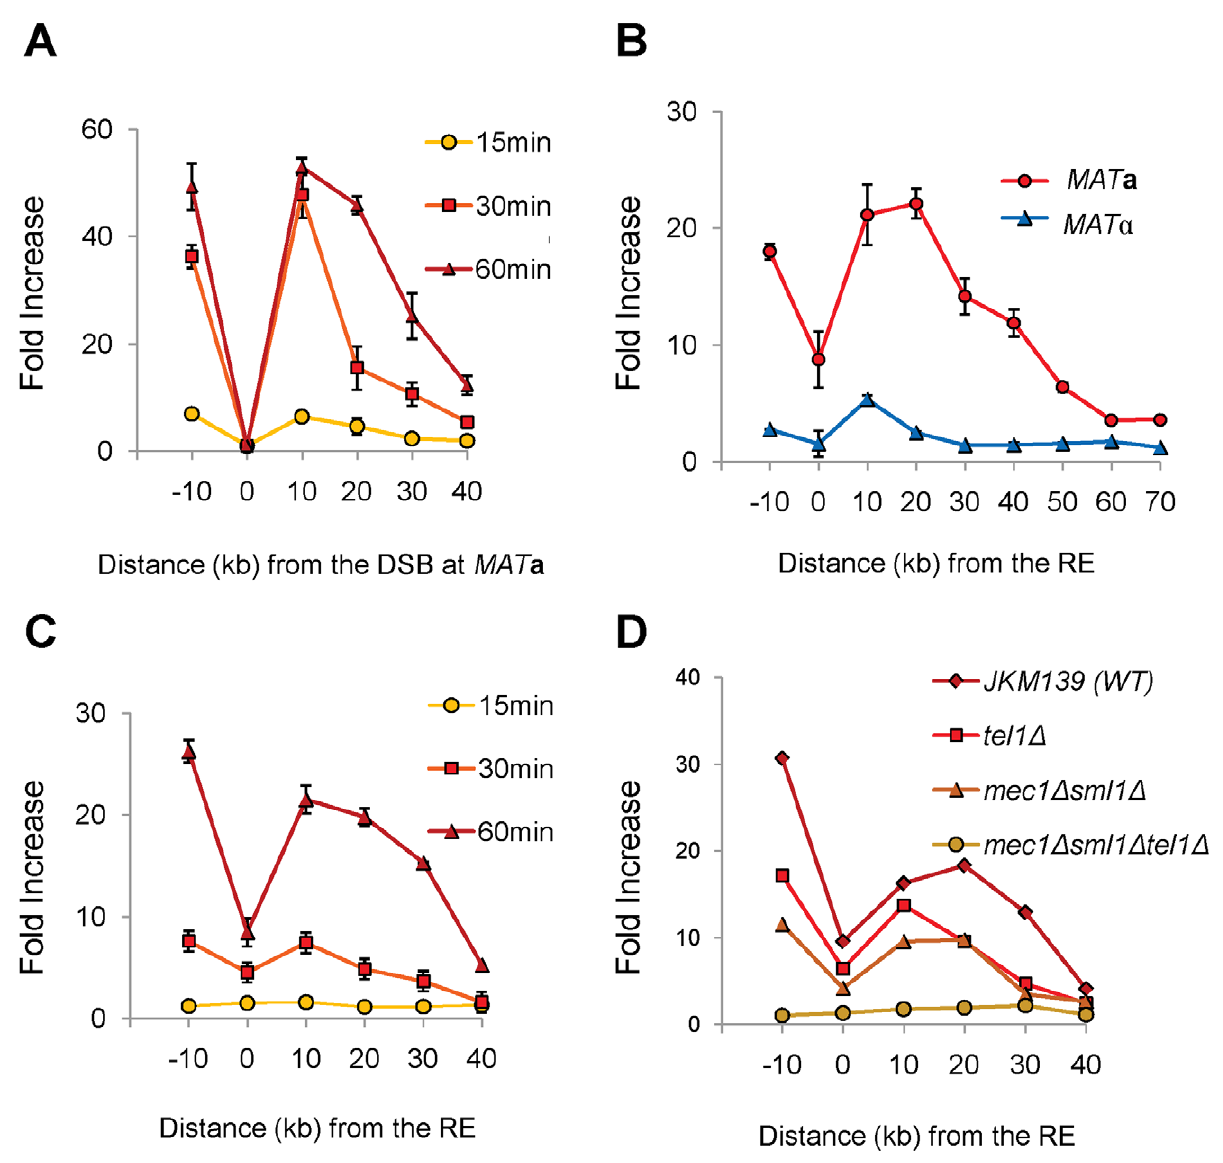
Figure 6. c -H2AX Formation around MAT Spreads to the RE Region in MAT a Cells. (A) c -H2AX formed around the MAT locus after DSB induction by HO. JKM139 ( MAT a ) lacking HML and HMR was grown in galactose and subjected to ChIP analysis with anti- c -H2AX antibody. DNA was extracted from immune-precipitates with protein G-agarose, and IP signals around the MAT locus were quantified via real-time PCR using five primer pairs ( 2 10 kb, 10 kb, 20 kb, 30 kb and 40 kb from the HO cut site). IP signal at each locus was normalized to that of a control locus CEN8 . Y axis represents IP signal as fold increase relative to the IP signal at the same locus before HO induction (time zero). Each data point is the average of two separate experiments, with error bars representing the range of IP values. (B) c -H2AX appeared around the RE region in MAT a , but not in MAT a cells. JKM139 ( MAT a ) and JKM179 ( MAT a ) cultured in galactose for an hour were subjected to ChIP with anti- c -H2AX antibody as described in panel A. To test c -H2AX PCR signals around the RE, primers pairs at various distances from RE were used. Error bars represent the range of IP values from two independent experiments. (C) Kinetics of c -H2AX formation around RE in JKM139 ( MAT a ). All experimental procedures are same as described in Panel A for primer pairs amplifying regions around RE. Two independent experiments were performed and error bars represent the range of IP values. (D) The level of c -H2AX signals around RE at 1 hr after HO induction was compared among the wild type (JKM139), tel1 D , mec1 D sml1 D or mec1 D sml1 D tel1 D